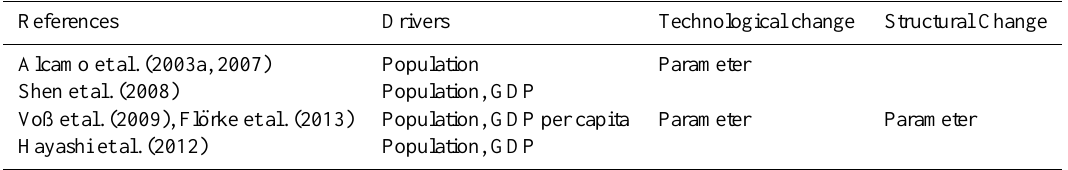
Table 4. Summary of municipal water withdrawal estimation models in earlier studies.